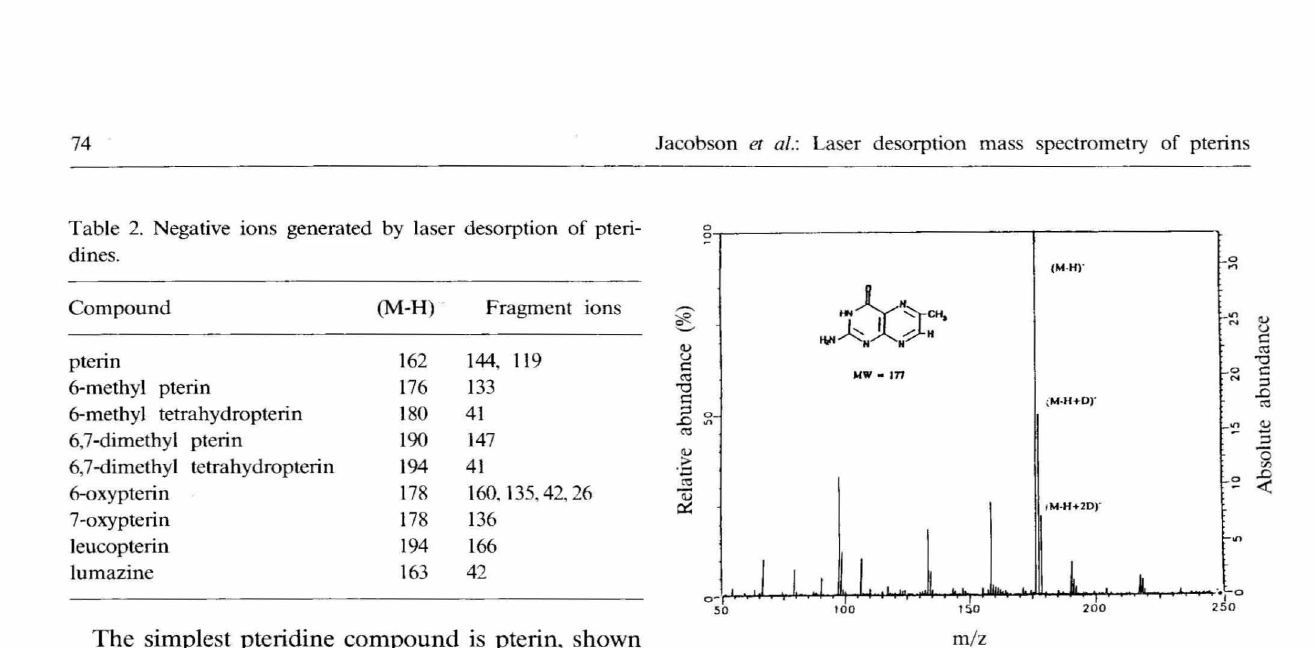
Figure 2. Negative ion laser desorption FTMS spectrum of 6-methylpterin dissolved in D 2 0